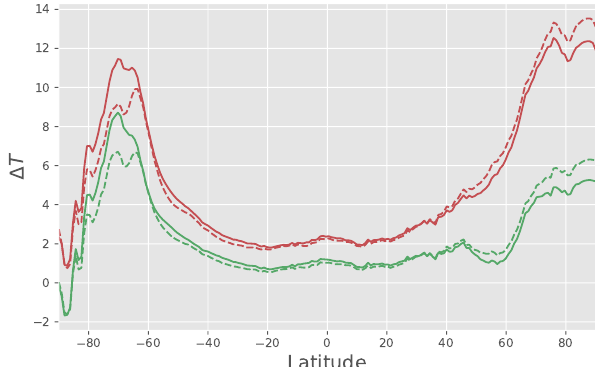
Figure 8. The zonally averaged climatological surface air tem- perature anomalies of the 400ppmv mid-Pliocene simulation (cid:104) 2691 , 2720 (cid:105) compared to the PI control (cid:104) 5131 , 5160 (cid:105) (red) and the modern control (cid:104) 1931 , 1960 (cid:105) (green). The solid lines are the anoma- lies computed within the set of simulations that are characterized by the POP1 profile of ocean diapycnal diffusivity, and the dashed lines are the anomalies computed within the set of simulations with the constant background diapycnal diffusivity. The (cid:104)(cid:105) denotes the range of model years over which the climatology was computed. Anomaly is defined as Pliocene minus